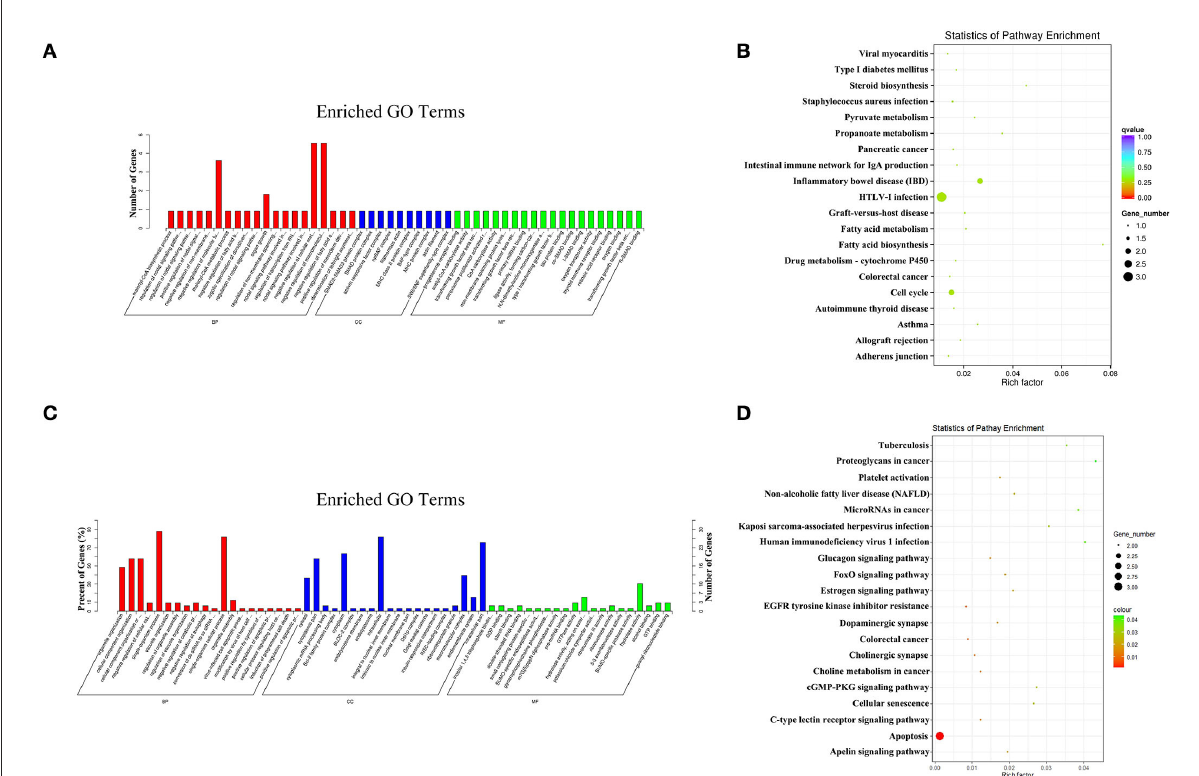
FIGURE7 The most enriched GO terms (A) and KEGG pathways (B) of the target genes of the DE miRNAs identified in PL vs. EL comparison. The most enriched GO terms (C) and KEGG pathways (D) of the parental genes of the DE circRNAs identified in PL vs. EL comparison.